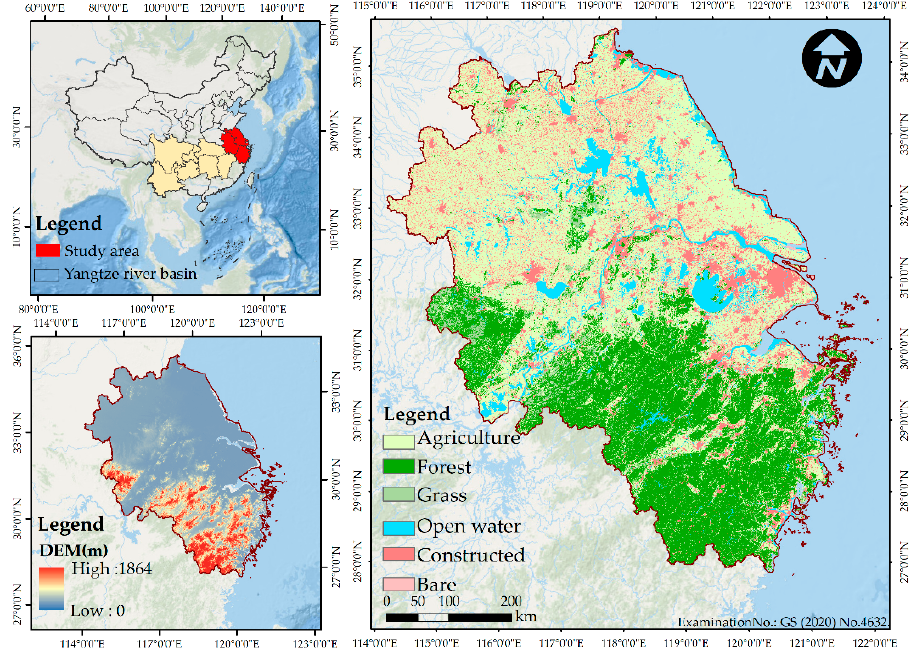
Figure 1. Land use and geomorphology of the study